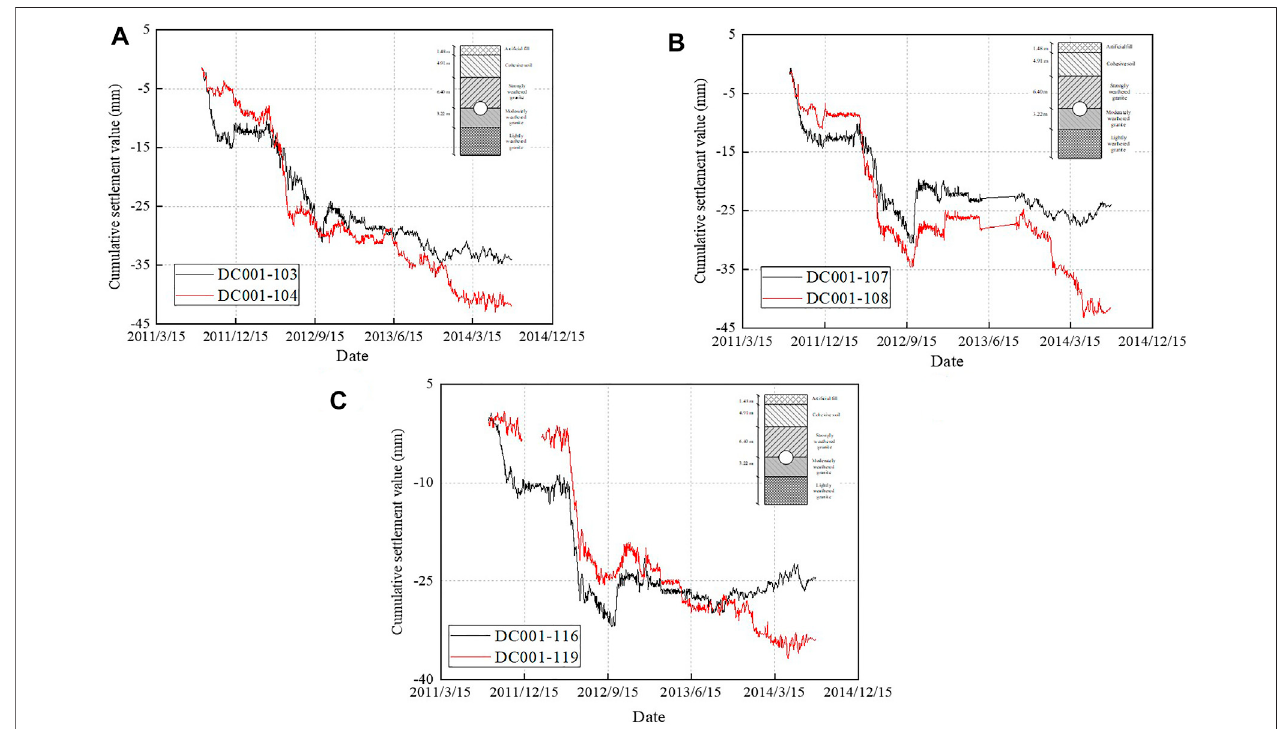
FIGURE 4 | Settlement change curve of Zhongshan Park Station. (A) DC001-103, DC001-104; (B) DC001-107, DC001-108; (C) DC001-116, DC001-119.